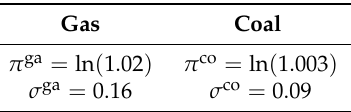
Table 1. Dynamical